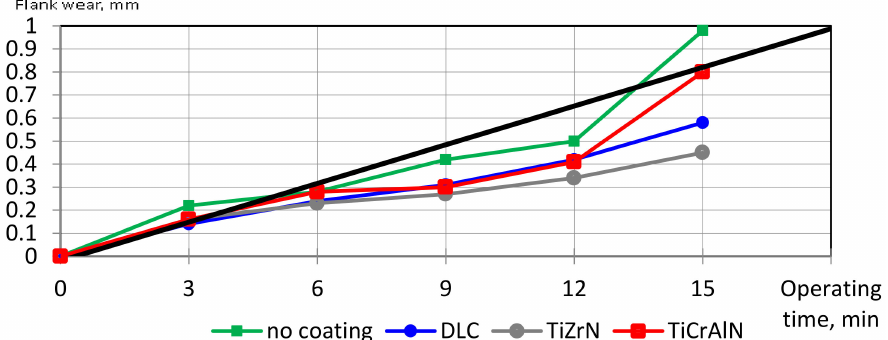
Figure 15. Dependences of the wear of the back surface of the Al 2 O 3 + SiC ceramic cutting inserts with various coatings on operating time for the milling of hardened steel 102Cr6 with the following cutting conditions: V = 380 m/min, S = 0.1 mm/tooth, and t = 1